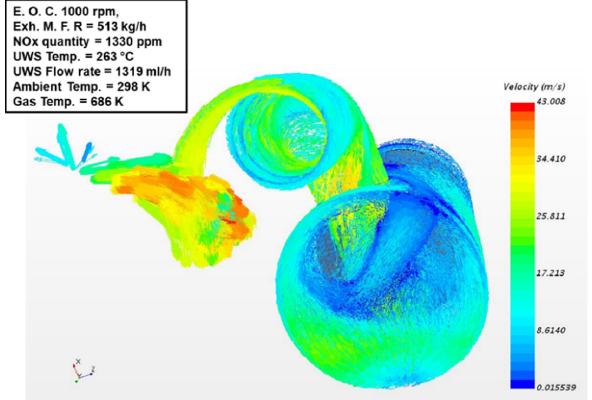
Figure 3. The urea distribution pattern in the SCR system.